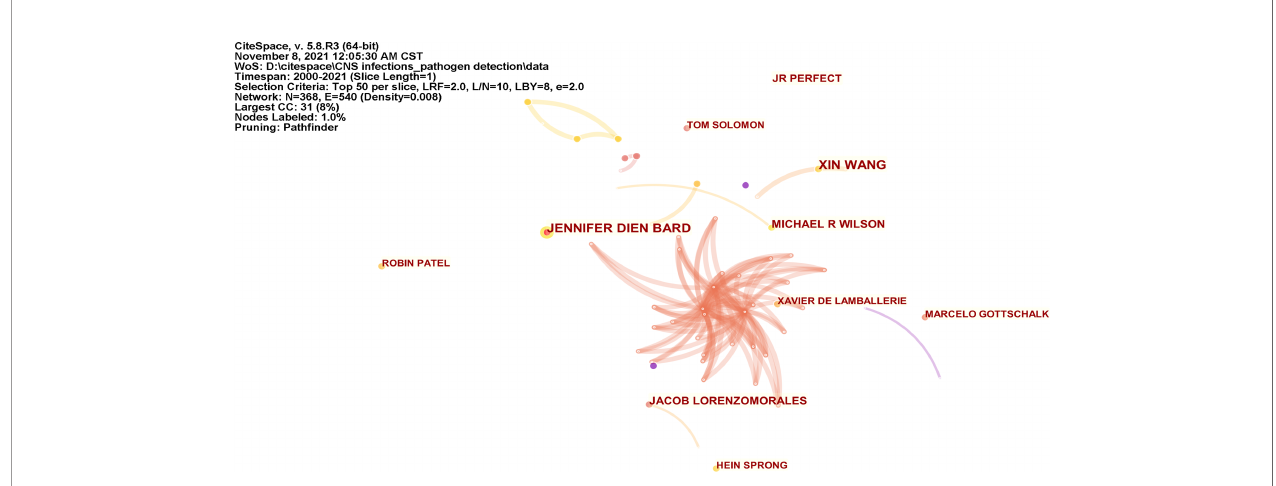
FIGURE 9 | Visualization map of the scienti fi c collaboration network analysis